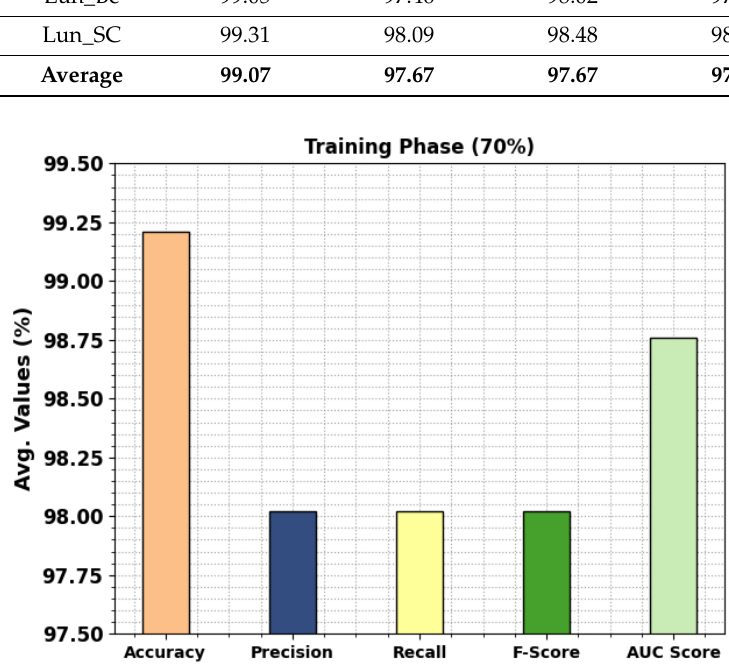
Figure 7. Average outcomes of MPADL-LC3 algorithm on 70% of TRS.